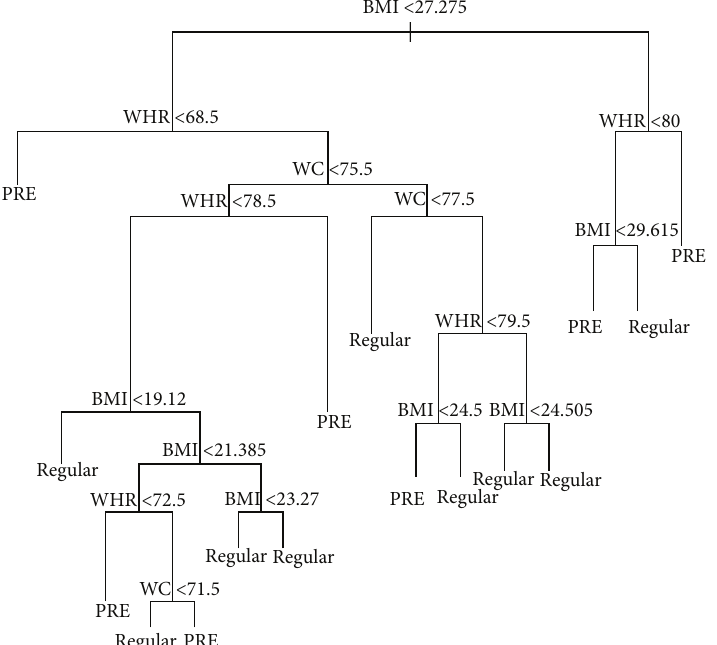
Figure 1: Best model for women. Notice that the endpoint for women is systolic blood pressure greater than 120mmHg (prehypertension).